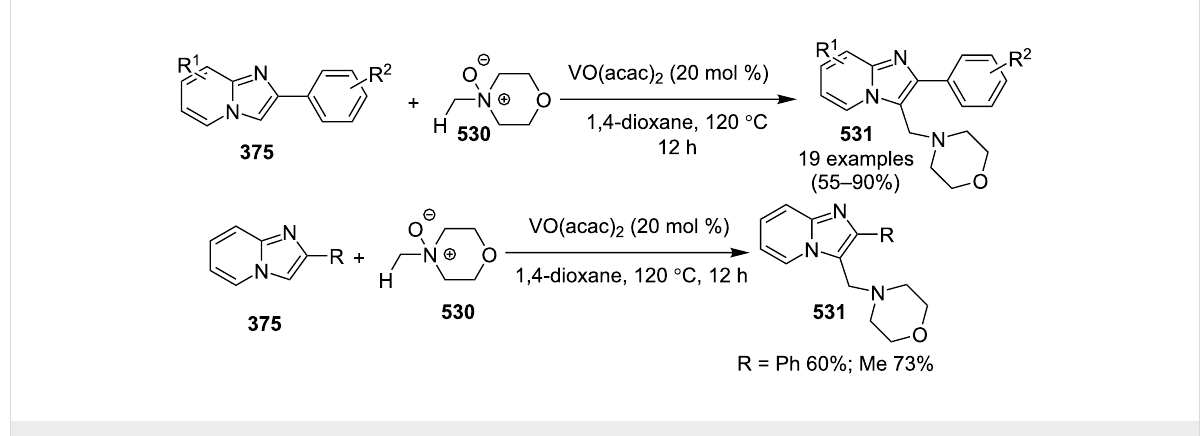
Scheme 187: Vanadium-catalyzed coupling of IP and NMO.